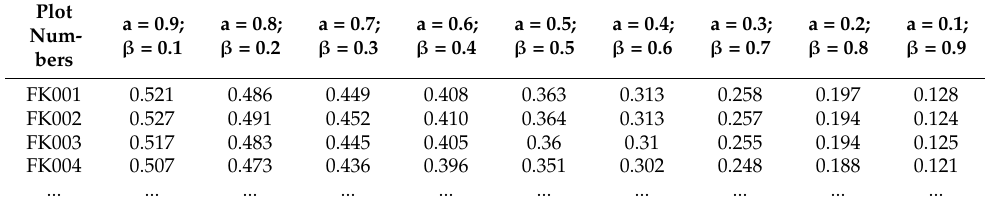
Table 4. Closeness degree under different